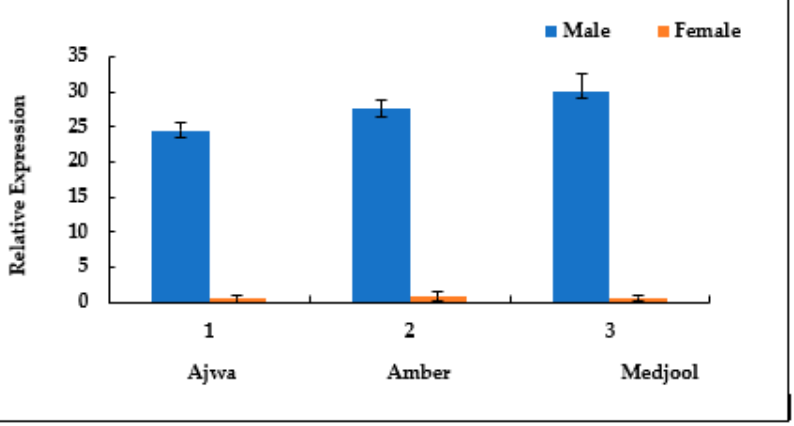
Figure 3. Comparative TPD1-like gene expression in the leaves of selected date palm suckers. Error bar indicates the ±SE of three replicates.